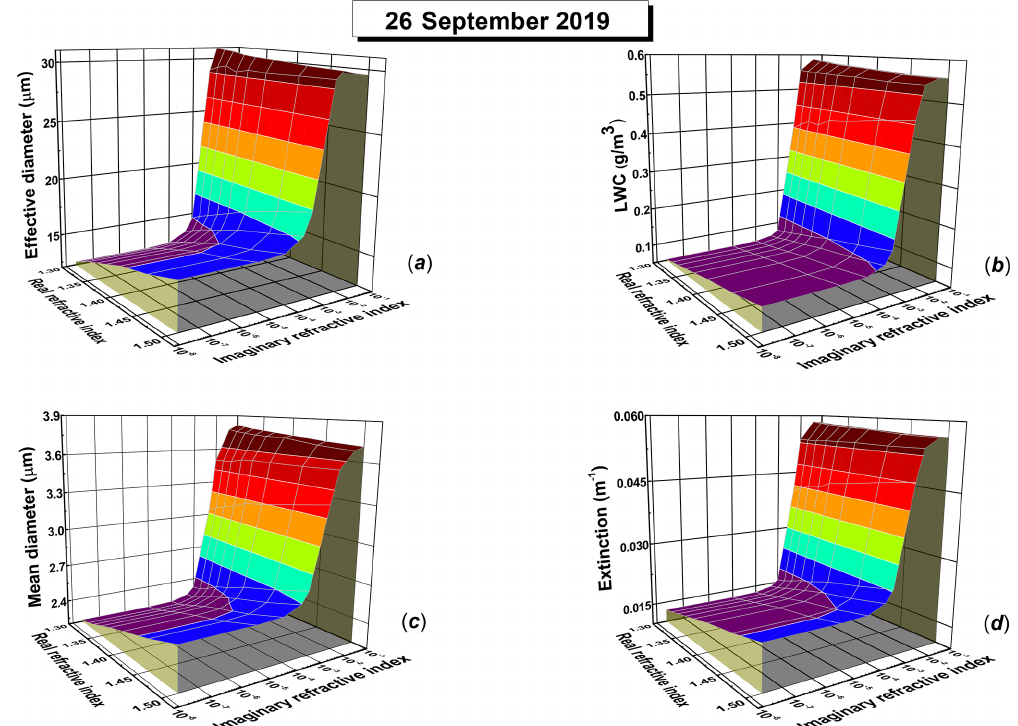
Figure 11. Effective diameter (a) , total LWC (b) , mean diameter (c) and extinction coefficient computed with the data used to construct Fig. 3b for which the droplet sizing has been performed by assuming the particles have various values of the real and imaginary parts of the refractive index. Each diagram shows a steep increase for imaginary (absorption) index larger than about 0.001, which suggests that droplet sizing is largely underestimated in clouds contaminated with substances that highly absorb the wavelength of the CAS